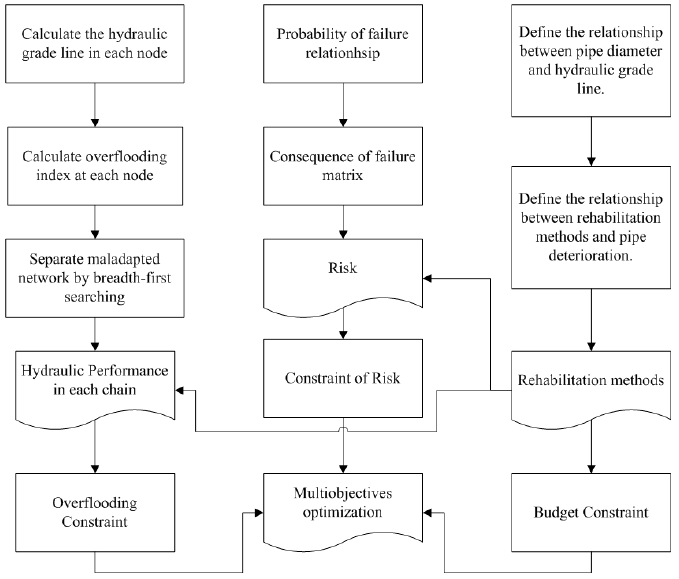
Figure 1. Structure of the HRCM model.